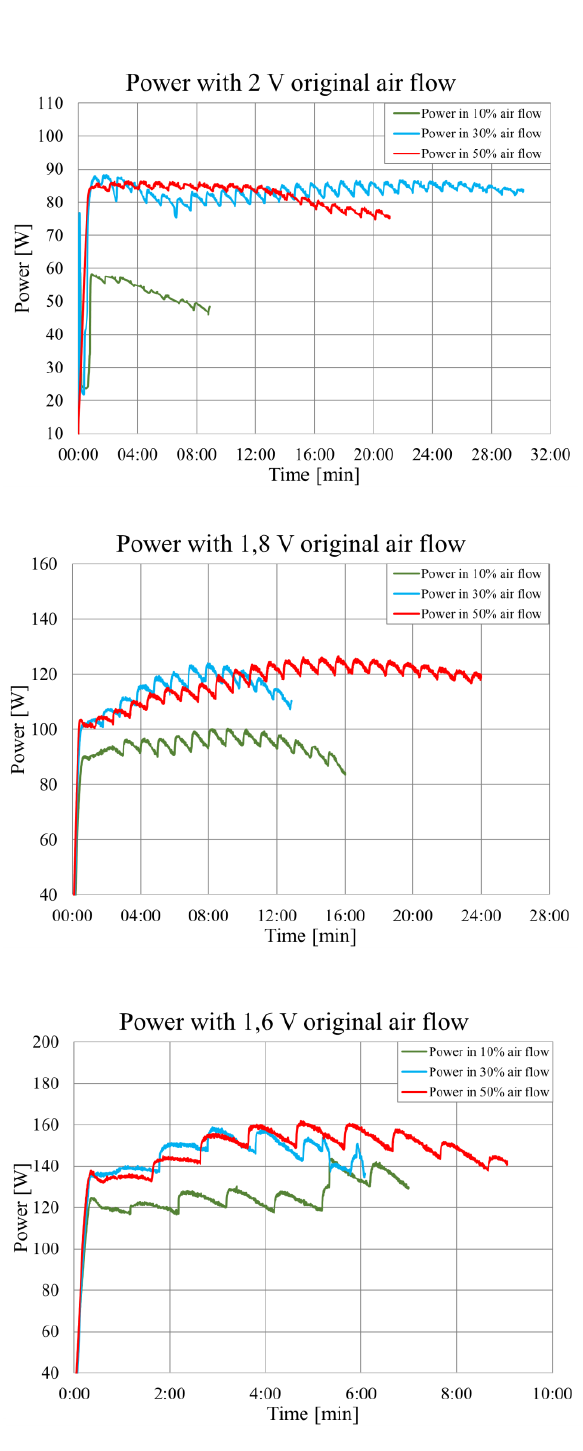
Fig. 5 . Dependence of fuel cell performance on air flow and voltage – optimised adapter .